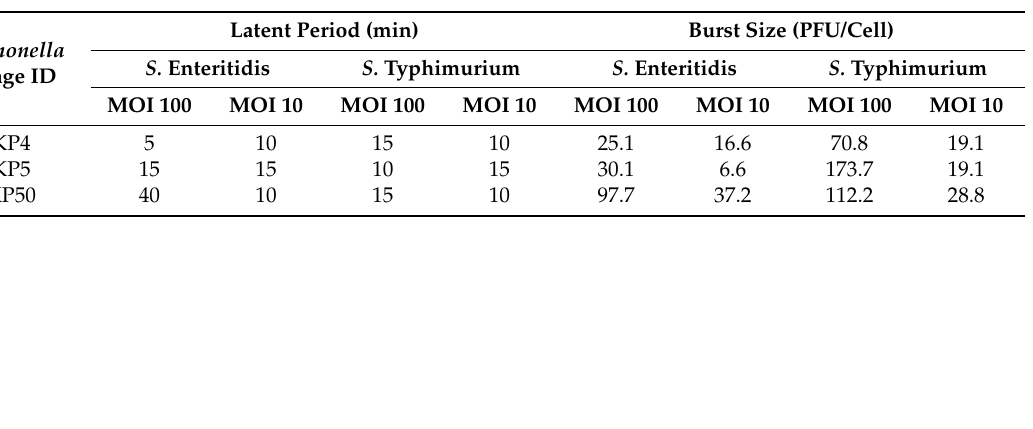
Table 6. Latent period and burst size of Salmonella phages included in a phage cocktail